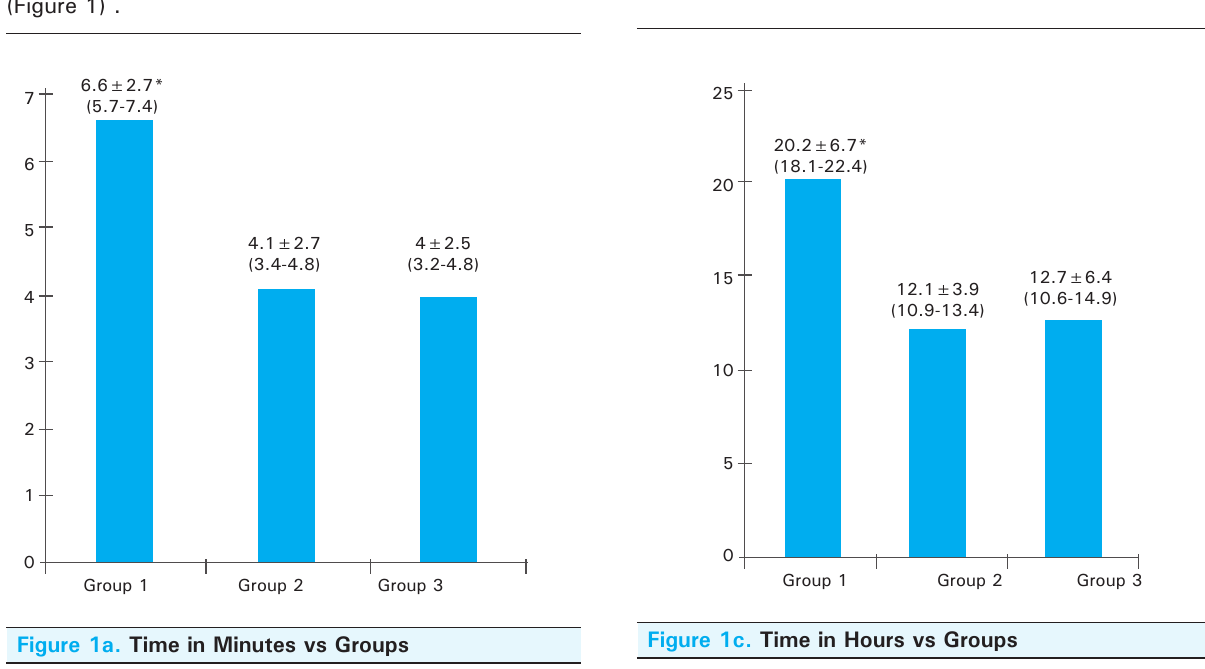
Figure 1c. time in hours vs groups Figure 1a. time in Minutes vs groups